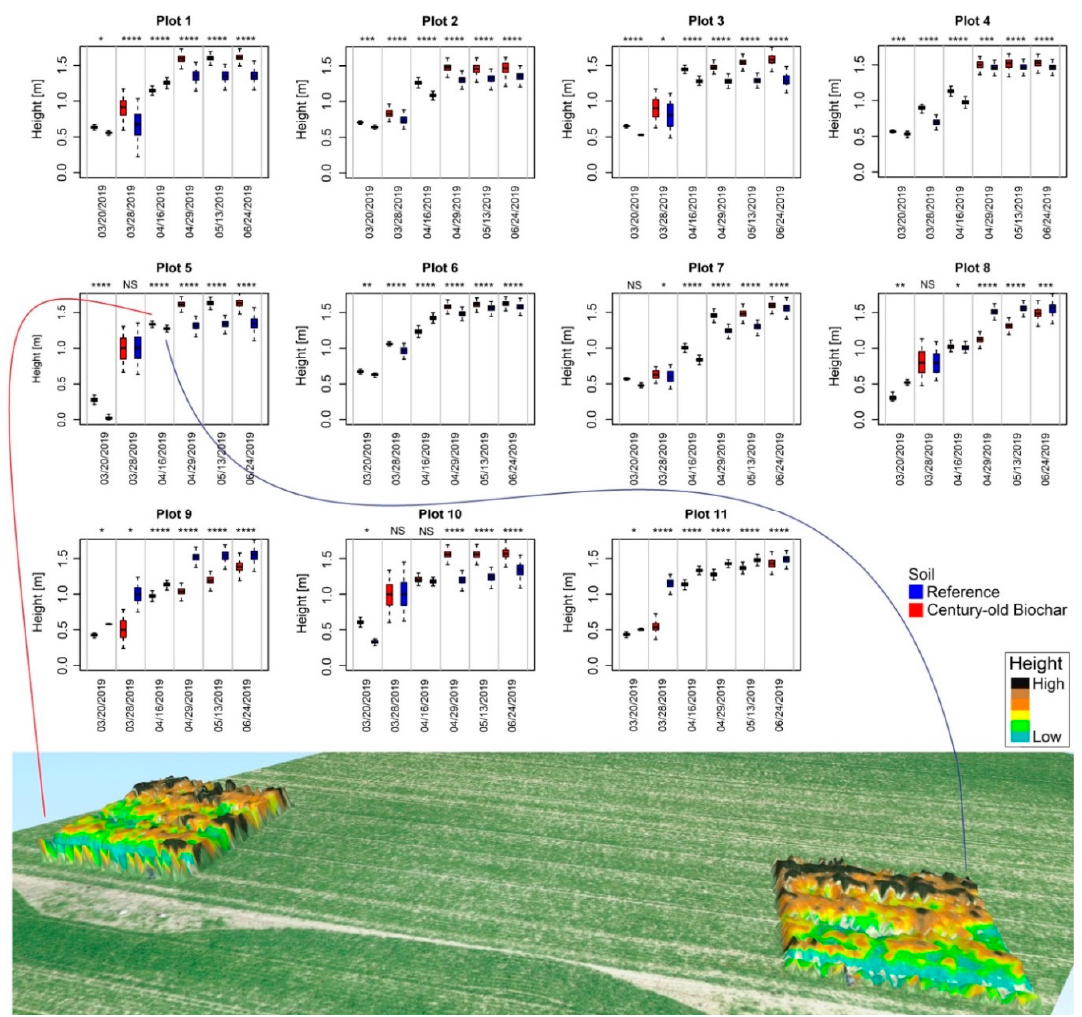
Figure 6. Box plot visualization of winter wheat height development for the 11 experimental pairs of century-old biochar versus reference plots. The horizontal black line displays the median value, surrounded by box edges representing the 25th and 75th percentiles. Outside of the plot, asterisks *, **, ***, and **** reveal the statistical levels of significance and the acronym NS stands for non-significant. The bottom magnified window displays an example of a height comparison between century-old biochar and reference plot 5 (i.e., on 16 April 2019).